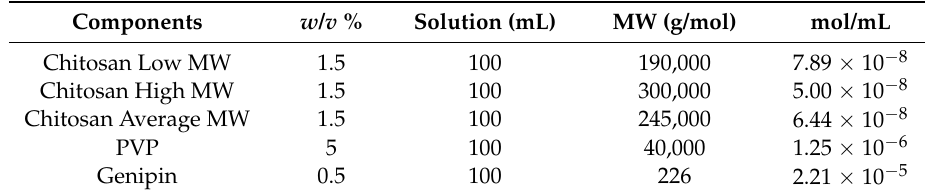
Table 1. Stock solution concentrations.